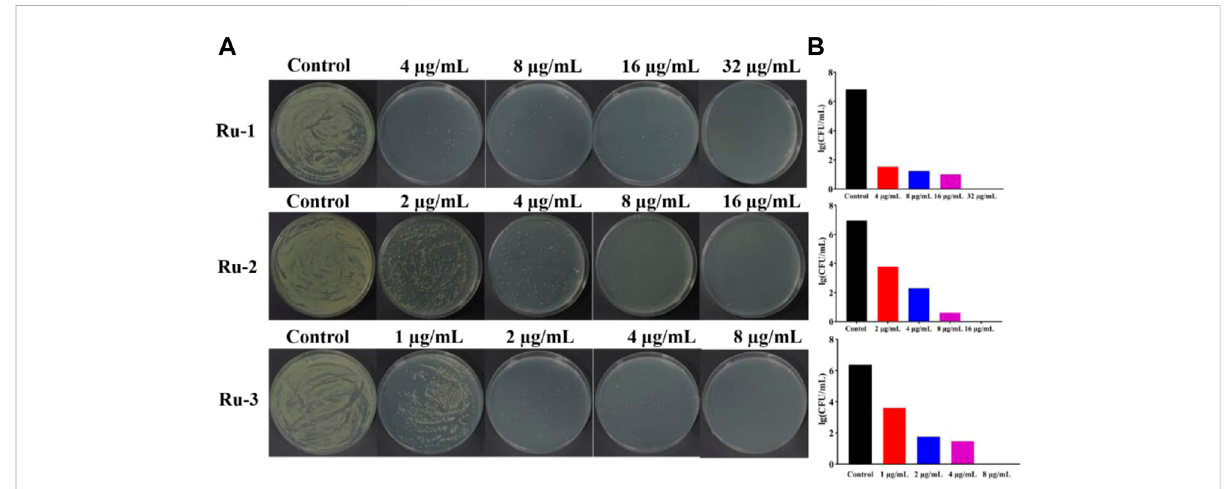
FIGURE 4 Ruthenium complex inhibited the growth of wild-type Staphylococcus aureus for 2 h (A) the plate experiment diagram. (B) the plate counting diagram.